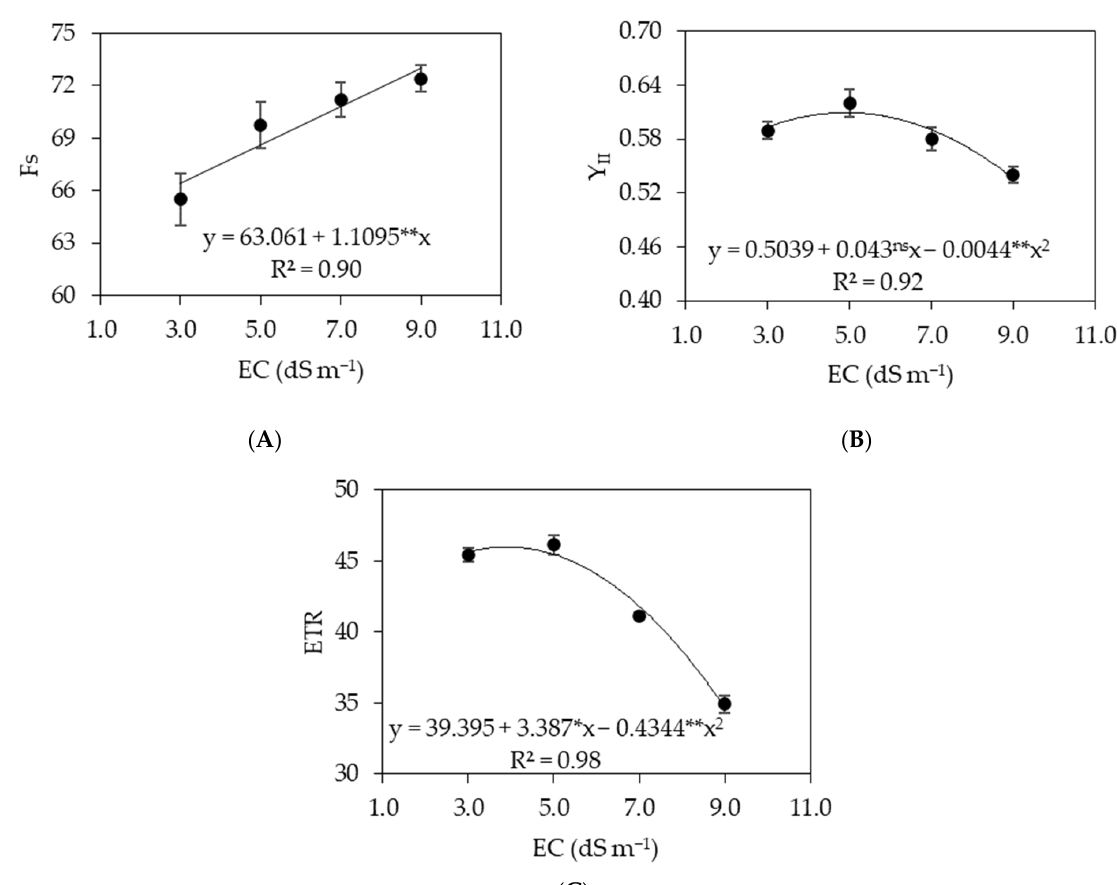
Figure 15. Initial fluorescence before saturating pulse—Fs ( A ), quantum efficiency of photosystem II in the light phase—Y ( B ), and electron transport rate—ETR ( C ) of ‘Canindé’ okra cultivated in a hydroponic system as a function of the electrical conductivity of the nutrient solution (EC) 60 days after transplanting. * and ** significant at p ≤ 0.05 and ≤ 0.01, respectively. The vertical lines represent mean +/ − standard error (n = 4).